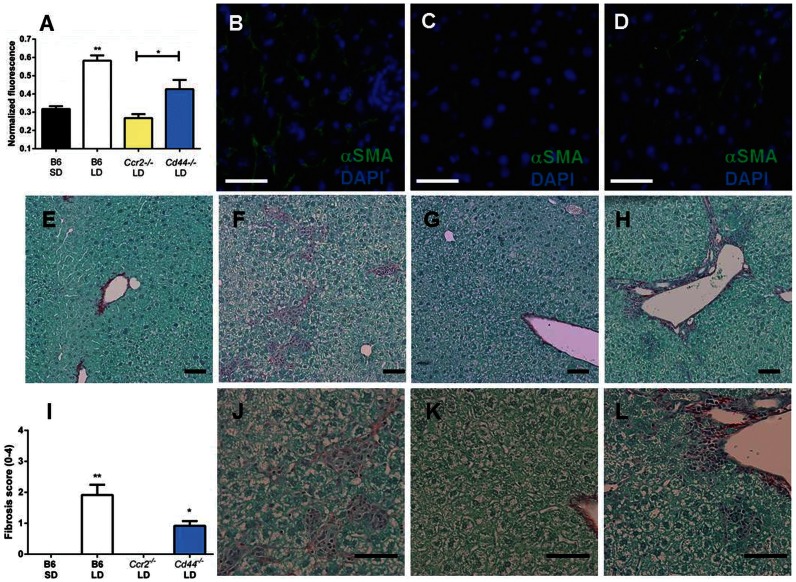
Livers from LD fed B6 mice display activated stellate cells and fibrotic lesions.(A) Liver tissue sections were stained with α-smooth muscle actin antibody (αSMA) and cell nuclei were stained with DAPI. α-smooth muscle actin signal (green fluorescence) was normalized to cell number (blue fluorescence) (n = 4 mice per group, 5 tissue sections per mouse; *P<0.05 compared to Ccr2−/− mice; **P<0.05 compared to all groups). A representative section from LD fed B6 mice (B), Ccr2−/− mice (C) and Cd44−/− mice (D). (E–H) Low and (J–L) high power magnification of pico-sirius stained SD fed B6 mice (E), LD fed B6 mice (F,J), Ccr2−/− mice (G,K) and Cd44−/− mice (H,L). (I) Fibrosis score was determined by sirius-red positive staining (**P<0.05 compared to all groups, *P<0.05 compared to B6 SD and Ccr2−/− LD). In E–H and J–L the bar corresponds to 25µm.